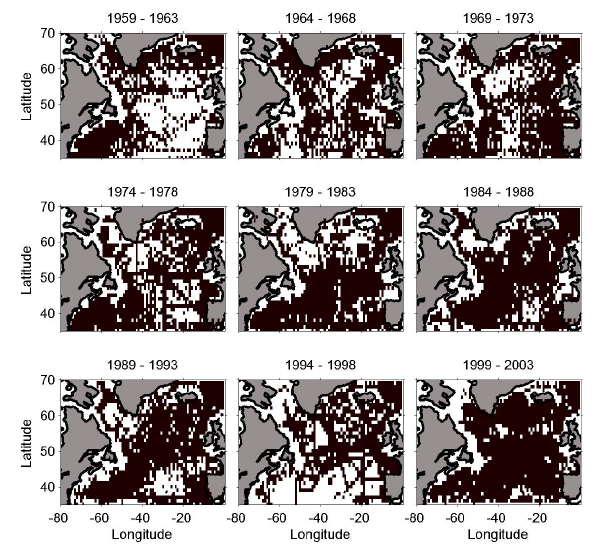
Fig. 1. Data distribution in the study area. Bins of 1 ◦ × 1 ◦ with at least one observation of the CliSAP data set in the period shown at the top of each panel are marked black. The panels correspond to those of Fig. 3a